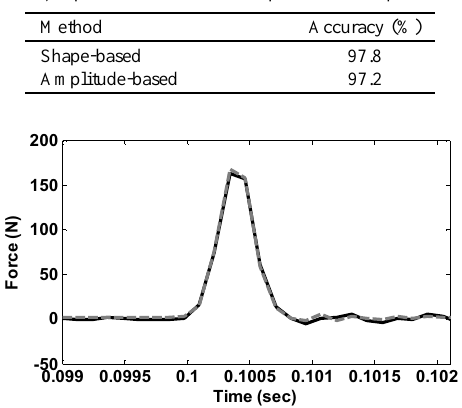
Table 3 Comparison of the ability to correctly locate isolat-